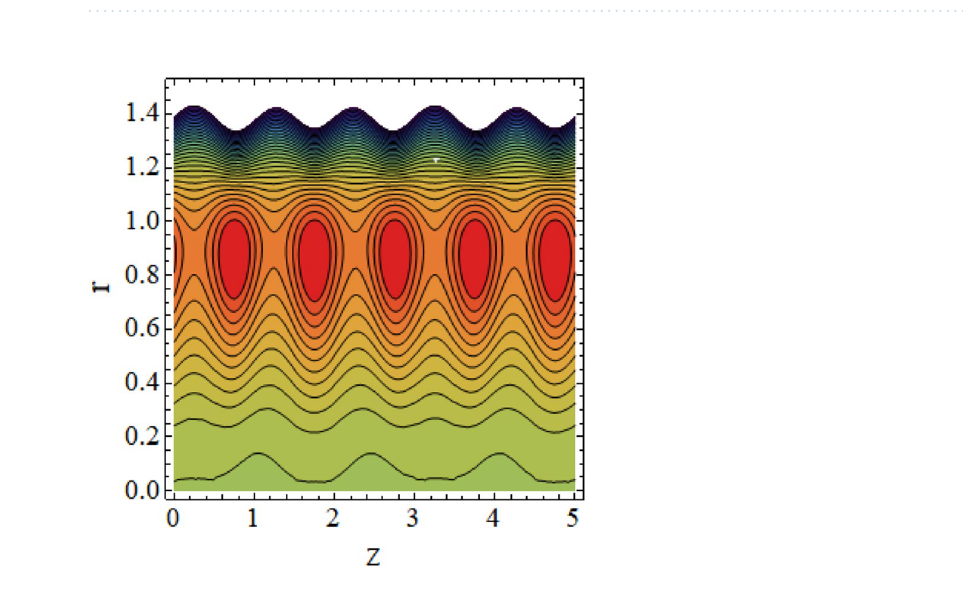
Figure 11. Temperature profile for σ l .